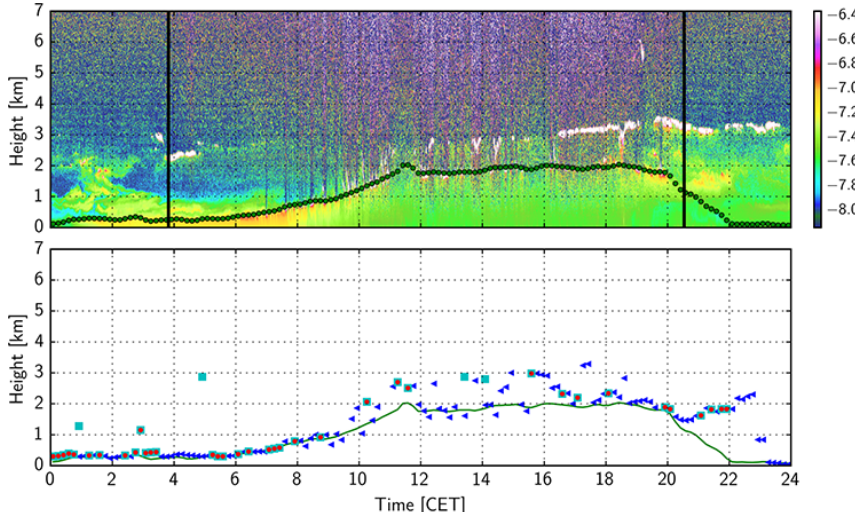
Figure 2. Top: time–height cross section of range-corrected ceilometer signals (Vaisala CL51) at the BLUME network site 42, Nansenstraße, on 1 July 2014 (in arbitrary units). The MLH as determined from COBOLT ( H ml , c ) is marked by dark green dots. Bottom: comparison of the MLH retrievals: H ml , c as above (green line). H ml , v with L1 criterion (blue triangles), the L3 criterion (red dots) and the Q3 criterion (cyan squares); for the definition see Table